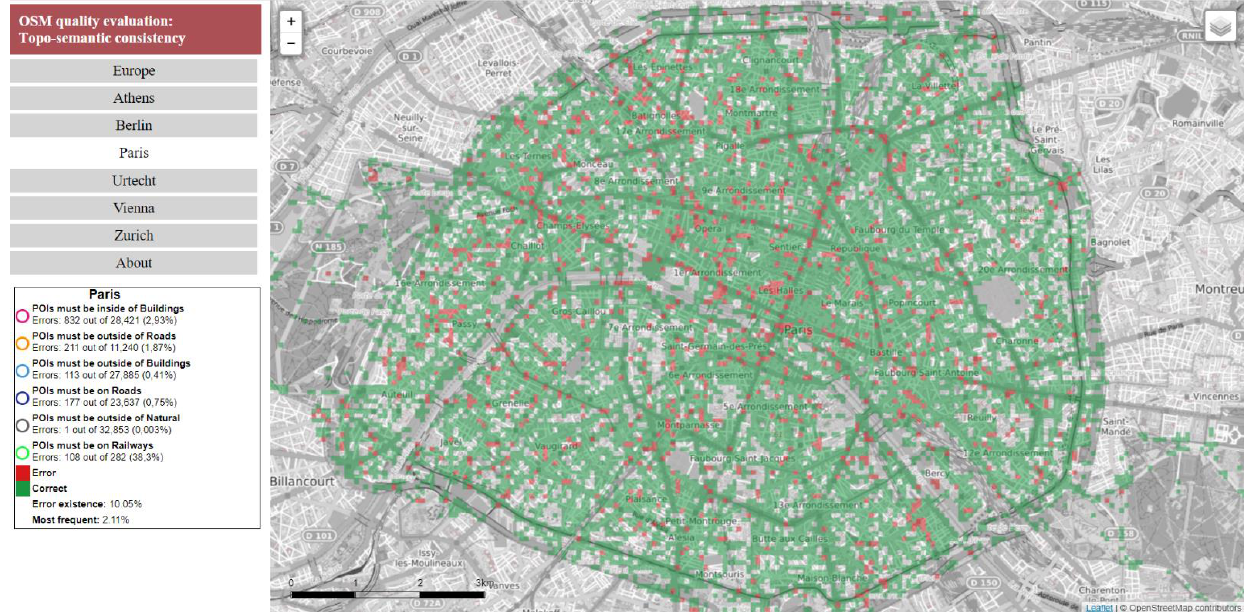
Figure A5. Consistency Grid (error existence) for Paris.